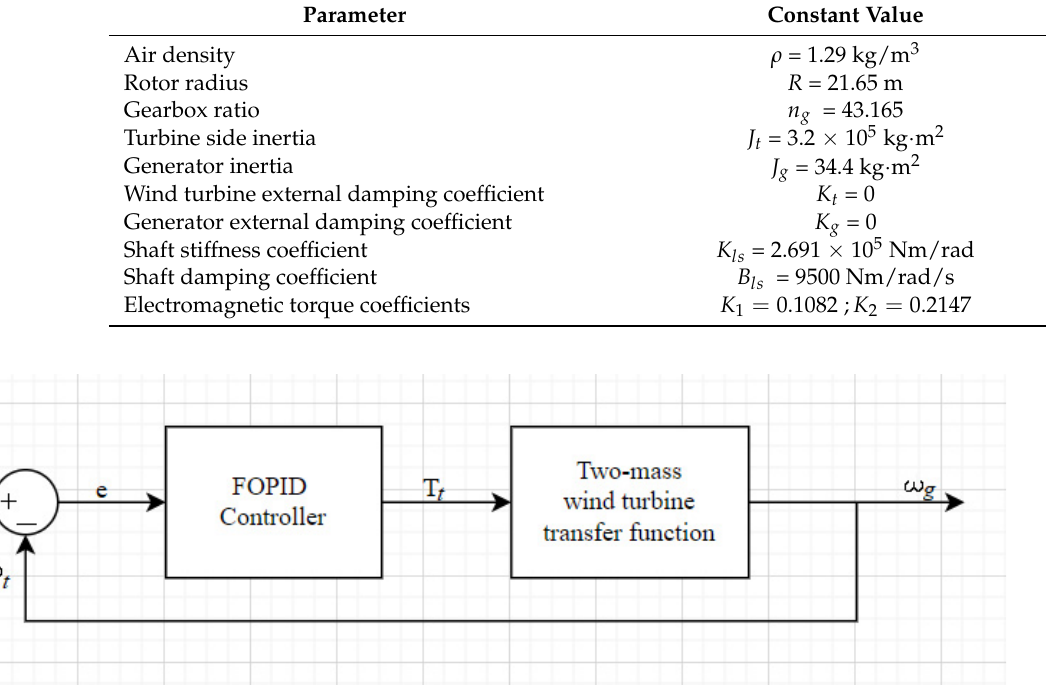
Figure 3. The control scheme for the two-mass wind turbine mathematical model.